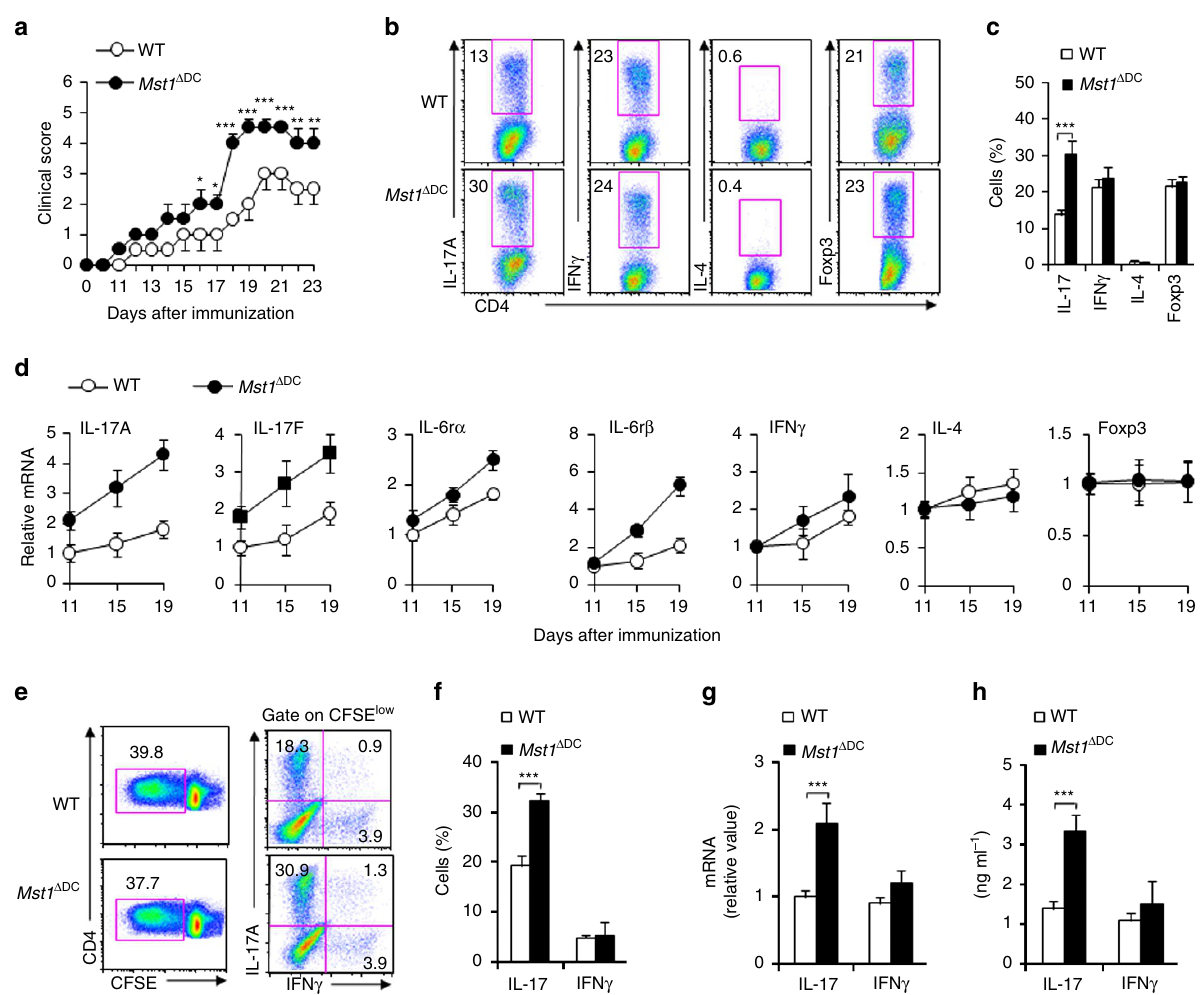
Figure 2 | DC MST1 inhibits Th17 differentiation in EAE. ( a ) EAE disease course in WTand Mst1 D DC mice. Intercellular staining of IL-17 þ cells, IFN g þ cells, IL-4 þ cells (after stimulation with PMA and ionomycin) and Foxp3 þ cells among CD4 þ T cells from the spinal cord of WT or Mst1 D DC mice were determined with flow cytometry method (FCM) on day 19 after MOG immunization. A typical figure is shown ( b ) and the data summarized ( c ). ( d ) CD4 þ Tcells isolated from spinal cord of Mst1 D DC mice on the indicated day after MOG immunization along with mRNA expression of the indicated gene (levels in WT groups were set to 1). ( e , f ) CD4 þ T cells isolated from dLN of MOG-immunized WT or Mst1 D DC mice were labelled with CFSE and stimulated with MOG for 5 days. Intercellular staining of IL-17 and IFN g in CFSE low cells was determined with FCM. The typical figure is shown in e and data summarized ( f ). ( g , h ) CD4 þ Tcells isolated from the dLN of MOG-immunized WTor Mst1 D DC mice, and ex vivo stimulation with anti-CD3 (1 m gml (cid:2) 1 ) for 24h and mRNA expression ( g ) or cytokine secretion ( h ) of the indicated gene were analysed using qPCR (levels in the WTgroups were set to 1) or ELISA. Data are representative of three to four independent experiments (mean ± s.d.; n ¼ 4–6). * P o 0.05 and *** P o 0.001, compared with the indicated groups. P -values were determined using Student’s t